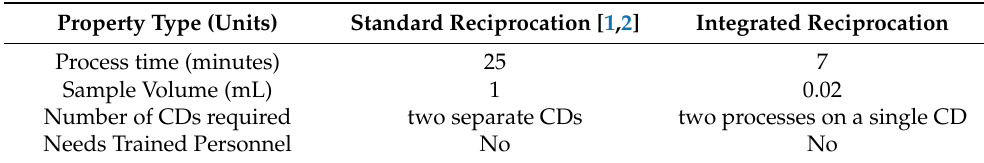
Table 1. Comparison of Integrated blood plasma separation with Standard Reciprocation system that uses two CDs